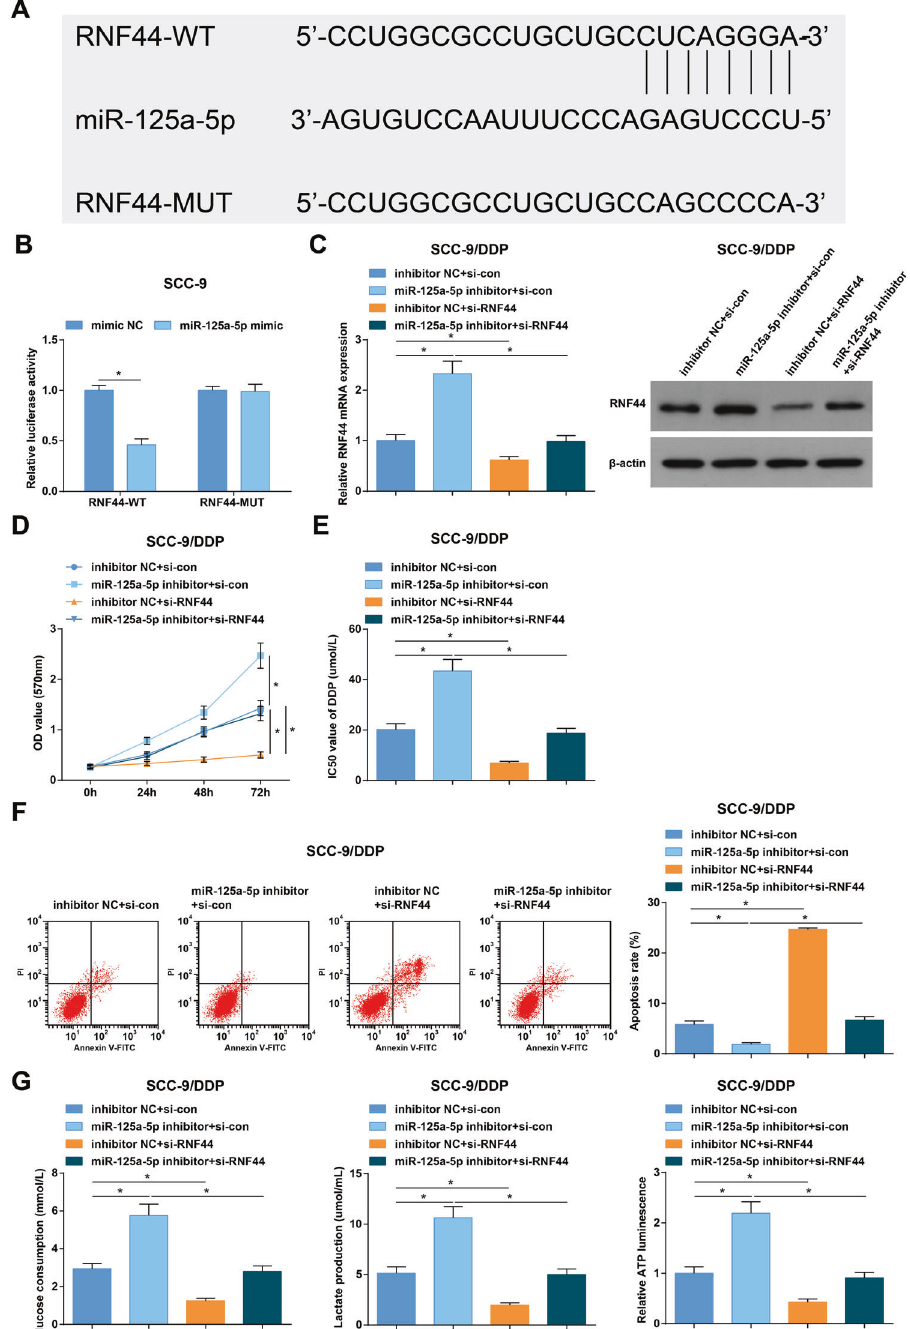
Fig. 6 MiR-125a-5p targets RNF44. A Binding sites between miR-125a-5p and RNF44 were predicted using Targetscan website; B Targeting relationship between miR-125a-5p and RNF44 was con fi rmed using dual luciferase reporter gene assay; C RNF44 expression in SCC-9/DDP cells after transfection of miR-125a-5p inhibitor + si-NC or miR-125a-5p inhibitor + si-RNF44 was detected using RT-qPCR; D Viability of SCC-9/ DDP cells was determined using MTT assay; E IC 50 of SCC-9/DDP cells was determined using MTT assay; F apoptosis of SCC-9/DDP cells was detected using fl ow cytometry; G glycometabolism of SCC-9/DDP cells was analyzed; N = 3; * P < 0.05; Data were expressed as mean ± standard deviation; t -test or ANOVA was used to analyze data. LncRNAs are known to regulate the biological function of miRNAs indicated an oncogenic role of MIR600HG in the development of by acting as a competitive endogenous RNA (ceRNA) [21]. In the OSCC. Yao et al. [12] have reported that MIR600HG suppressed present study, the interaction between MIR600HG and miR-125a-5p metastasis and enhanced oxaliplatin chemosensitivity by targeting was con fi rmed. Furthermore, our results suggested that miR-125a- ALDH1A3 in CRC. Due to the limited literature, the accurate 5p was expressed at a low level in OSCC cell lines and tissues, as well mechanism of MIR600HG needs further explorations in human as in DDP-resistant OSCC cells. In accordance with our fi nding, Cao cancers. Cell Death Discovery (2022)